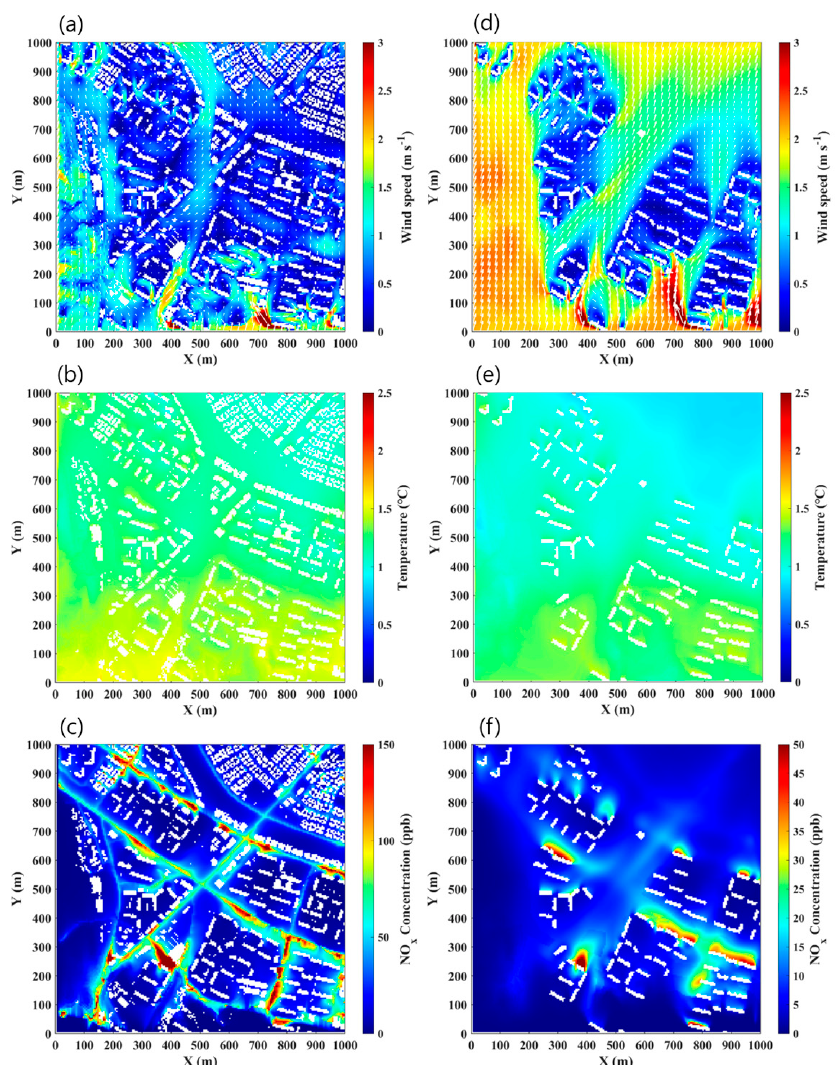
Figure 5. Simulated six-day averaged horizontal ( a ) wind speed, ( b ) air temperature, and ( c ) NO x concentration fields at a 1.5 m altitude and horizontal ( d ) wind speed, ( e ) air temperature, and ( f ) NO x concentration fields at a 30 m altitude during the P1D and P2D